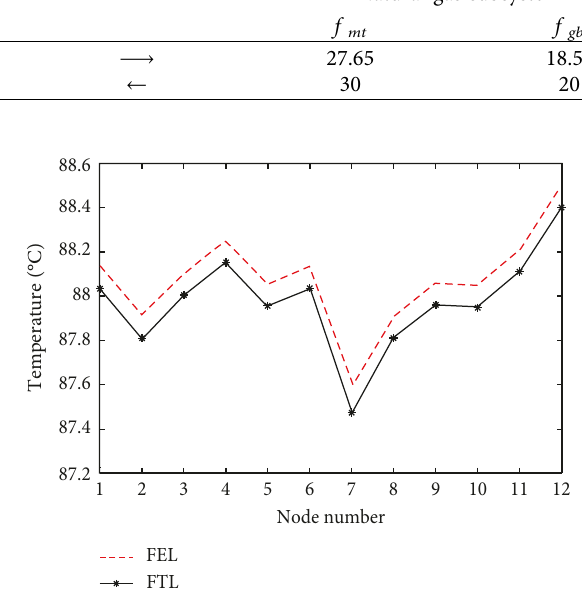
Figure 3: Voltage of each node in different modes.